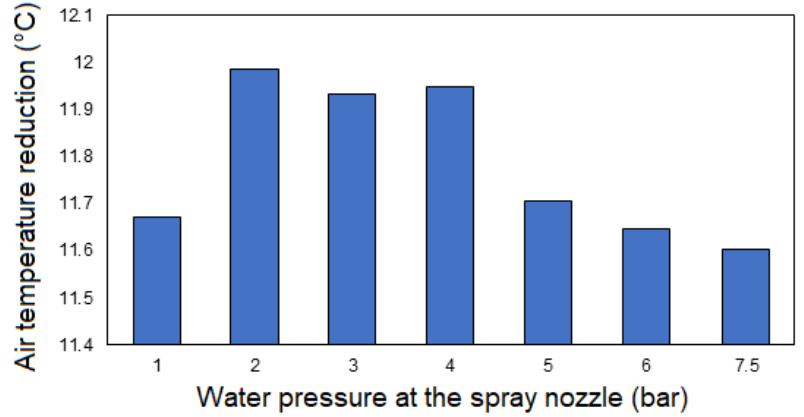
Figure 14. The influence of the water pressure at the spray nozzle on the temperature reduction = 40 ◦ C, RH = 24.5%, U = 4.4 m / (outdoor T = 40 °C, RH = 24.5%, U HWC = 4.4 m/s). (outdoor T HWC